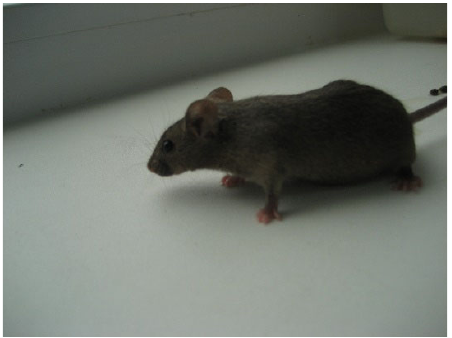
Figure 2. Clinically healthy (CBA×C57BI/6) F1 hybrid male mice.